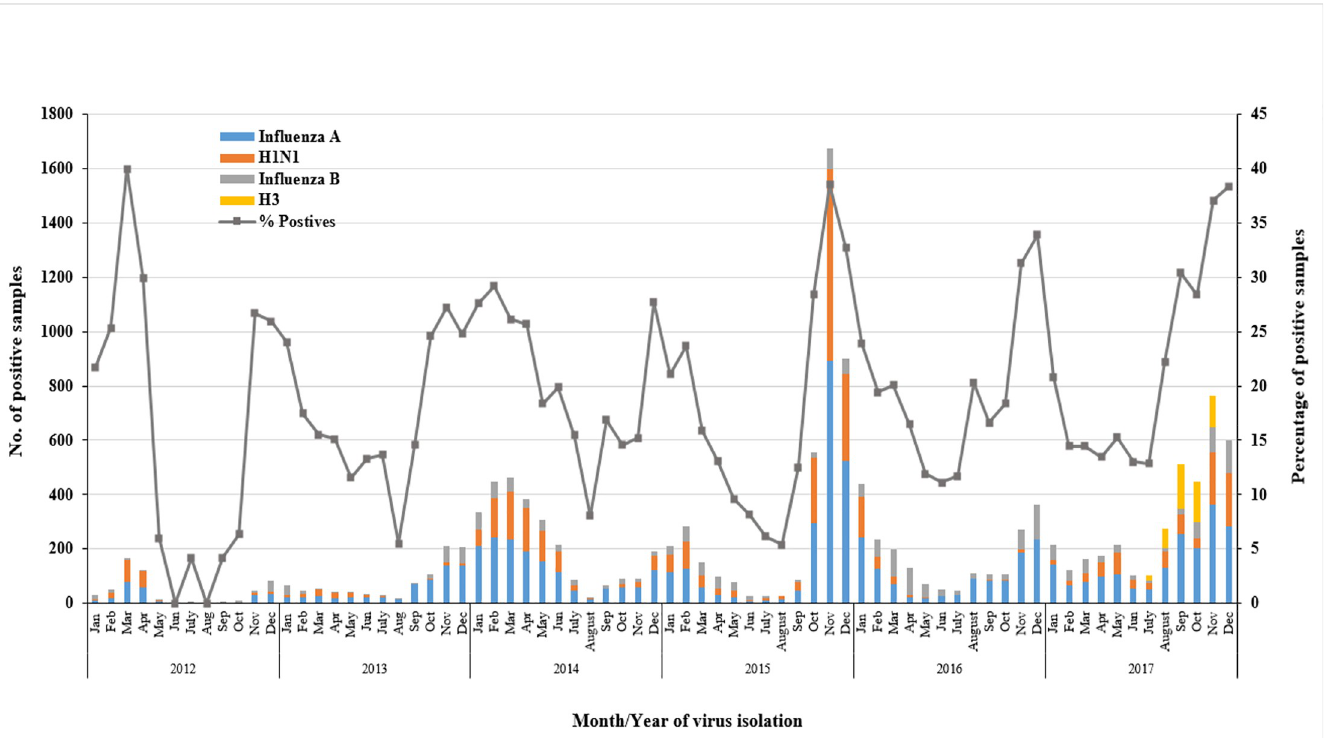
Fig 3. Seasonality of influenza viruses. The number of positive samples for each influenza type/subtype was calculated per month, from 2012 to 2017. The percentage of positive cases was calculated out of the total tested samples for influenza viruses (n =